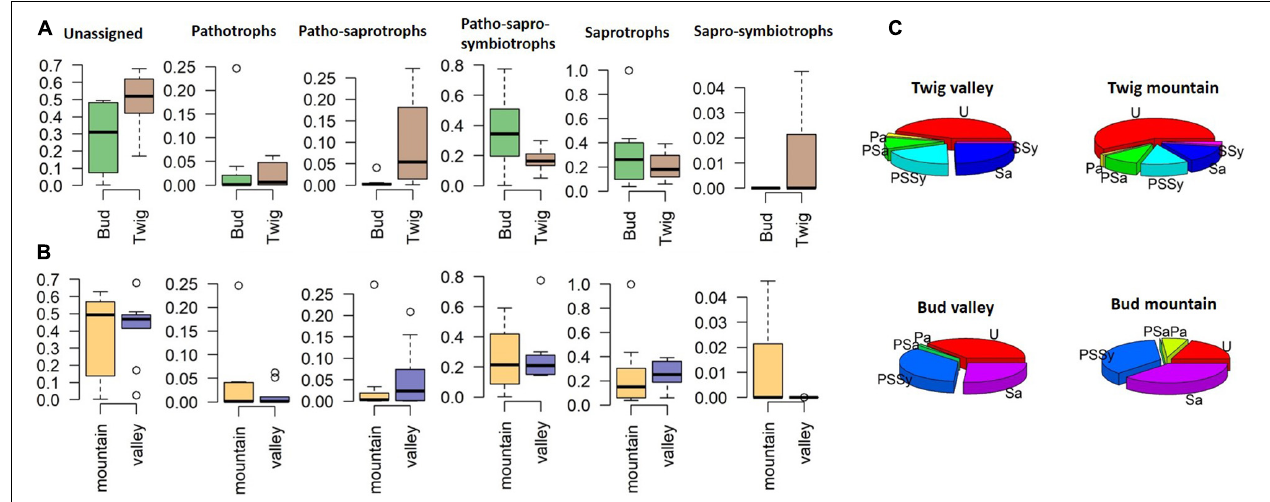
FIGURE 5 | Relative abundance of fungal endophytes divided on the basis of trophic guilds according to FUNGuild (Nguyen et al., 2016). (A) Site comparison, (B) substrate or organ comparison, and (C) pie charts displaying relative abundances per organ and site. U, unassigned; P, pathotrophs; PSa, patho-saprotrophs; PSSy, patho-sapro-symbiotrophs; Sa, saprotrophs; SSy, sapro-symbiotrophs.